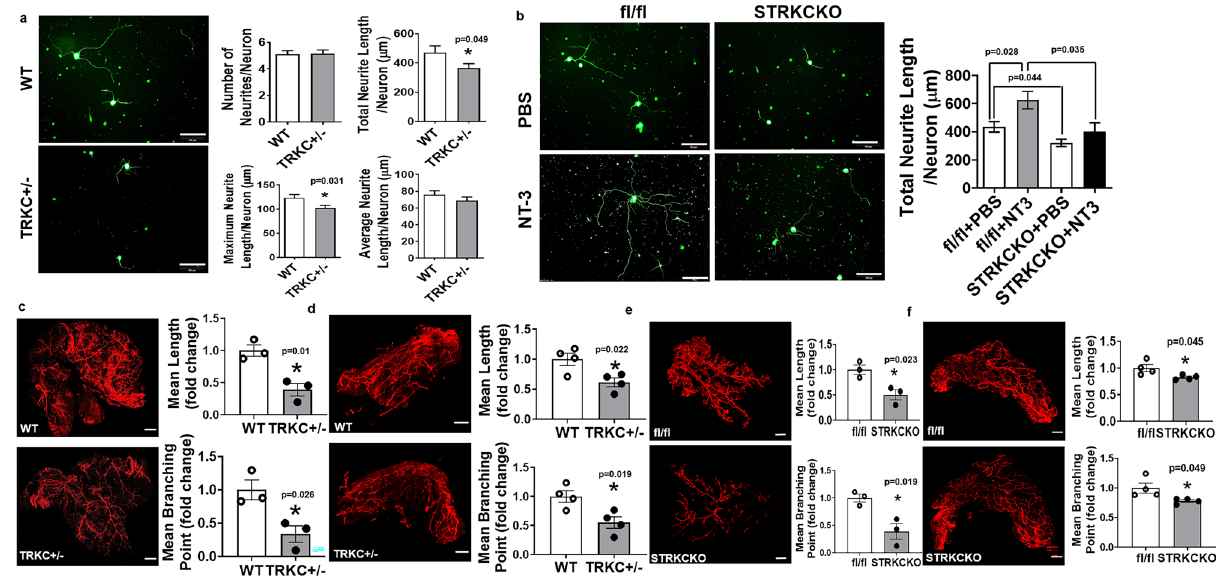
Fig. 5 TRKC is required for the neurotrophic effects of NT-3. a Representative β III-tubulin immuno fl uorescent images of sympathetic ganglia neurons isolated from WT and TRKC + / − mice (left panel, from three independent treatments/group, scale bar = 100 µ m) and quantitation of the number of neurites per neuron, total neurite length per neuron, maximal neurite length per neuron, and average neurite length per neurite per neuron (right panel, control n = 158, TRKC + / − n = 162, * indicates statistical signi fi cance between WT and TRKC + / − with unpaired two-tailed t test). b Representative β III- tubulin immuno fl uorescent images of sympathetic ganglia neurons isolated from fl / fl and STRKCKO mice treated with phosphate-buffered saline (PBS) or NT-3 (100 ng/ml) (left panel, from three independent treatments/group, scale bar = 100 µ m) and quantitation of total neurite length per neuron (right panel, fl / fl n = 135, fl / fl + NT-3 n = 49, STRKCKO n = 168, STRKCKO + NT-3 n = 42. Statistical signi fi cance was analyzed with two-way ANOVA. fl / fl vs STRKCKO F (1, 390) = 13.25 P = 0.0003; PBS vs NT-3 F (1, 390) = 7.680 P = 0.0059. * Indicates statistical signi fi cance with Turkey ’ s multiple comparisons test). Neurons from sympathetic ganglia at thoracic T1 – T4 levels from 6- to 8-week-old mice were isolated and used in these experiments. c , d Representative images of TH-positive sympathetic nerve innervation in eWAT ( c , left panel, from three replicate animals/group, scale bar = 2000 µ m) and iWAT ( d , left panel, from four replicate animals/group, scale bar = 2000 µ m) and quantitation of mean nerve fi ber length and mean nerve fi ber branching points normalized to total adipose tissue area in eWAT ( c , right panel, n = 3/group, * indicates statistical signi fi cance between WT and TRKC + / − with unpaired two-tailed t test) and iWAT ( d , right panel, n = 4/group, * indicates statistical signi fi cance between WT and TRKC + / − with unpaired two-tailed t test) in TRKC + / − mice and their littermate control mice after a 7-day cold challenge. e , f Representative images of TH-positive sympathetic nerve innervation in eWAT ( e , left panel, from three replicate animals/group, scale bar = 2000 µ m) and iWAT ( f , left panel, from four replicate animals/group, scale bar = 2000 µ m) and quantitation of mean nerve fi ber length and mean nerve fi ber branching points normalized to total adipose tissue area in eWAT ( e , right panel, n = 3/group, * indicates statistical signi fi cance between fl / fl and STRKCKO with unpaired two-tailed t test) and iWAT ( f , right panel, n = 4/group, * indicates statistical signi fi cance between fl / fl and STRKCKO with unpaired two-tailed t test) in fl / fl and STRKCKO mice after a 7-day cold challenge. All data are expressed as mean ±